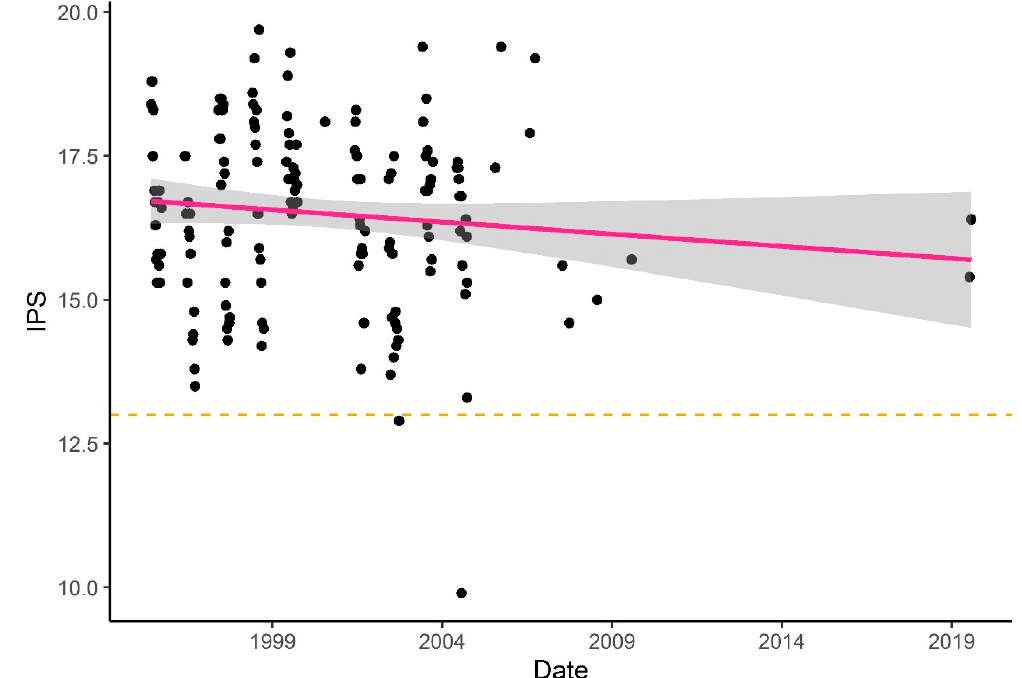
Figure 10. Values of the qualifying index are based on the composition of epiphytic diatom assemblages from deployed and natural reeds at a4 and a6 sites of the Á sv á ny tributary system. Confidence intervals of the linear trend line is fitted to the points (R 2 = 0.01, p = 0.176). Orange dashed line indicates good / moderate boundary of the